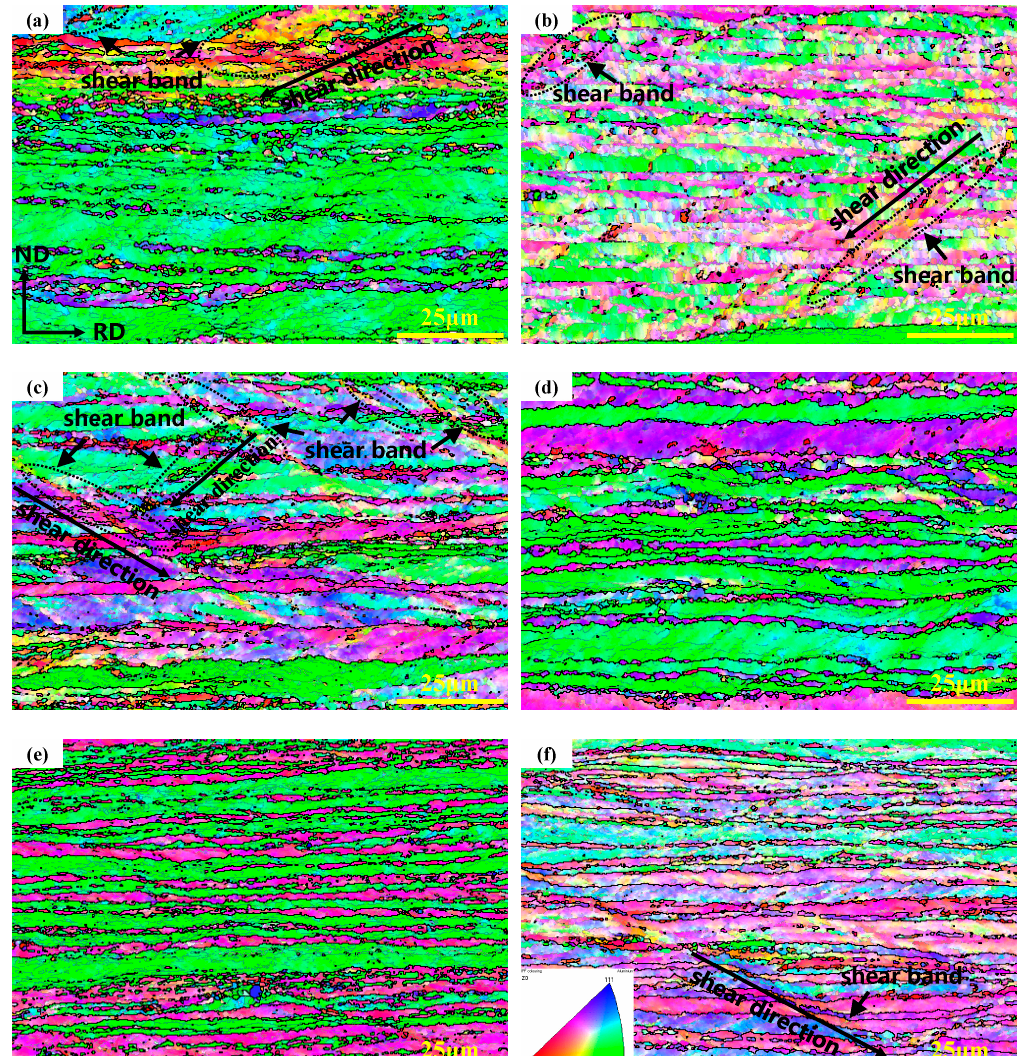
Figure 1. Electron backscatter diffraction (EBSD) image of cold rolled alloys: ( a ) Al-3Mg-0.5Mn; ( b ) Al-3Mg-0.5Mn-0.2Er; ( c ) Al-3Mg-0.5Mn-0.2Zr; ( d ) Al-3Mg-0.5Mn-0.2Cu; ( e ) Al-3Mg-0.5Mn-0.2Si; ( f ) Al-3Mg-0.5Mn-0.2Zn.